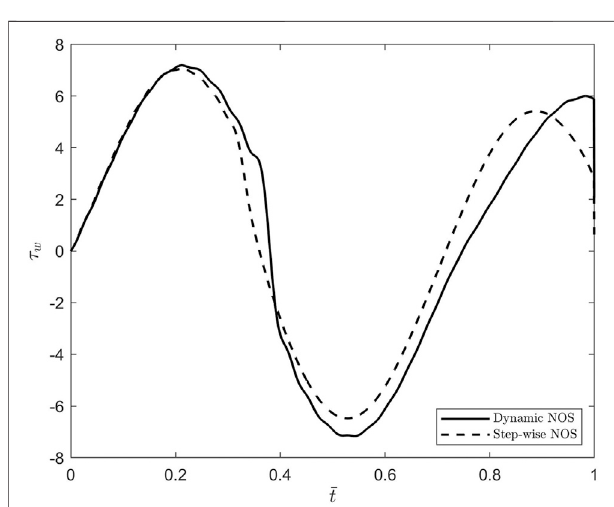
FIGURE 8 | Plots of the dimensionless shear stress at the bloodvessel interface τ w versus the dimensionless time (cid:2) t for the variable fractional order α ( t ) corresponding to the case of dynamic NOS (solid line) and to the case of stepwise NOS (dashed line).